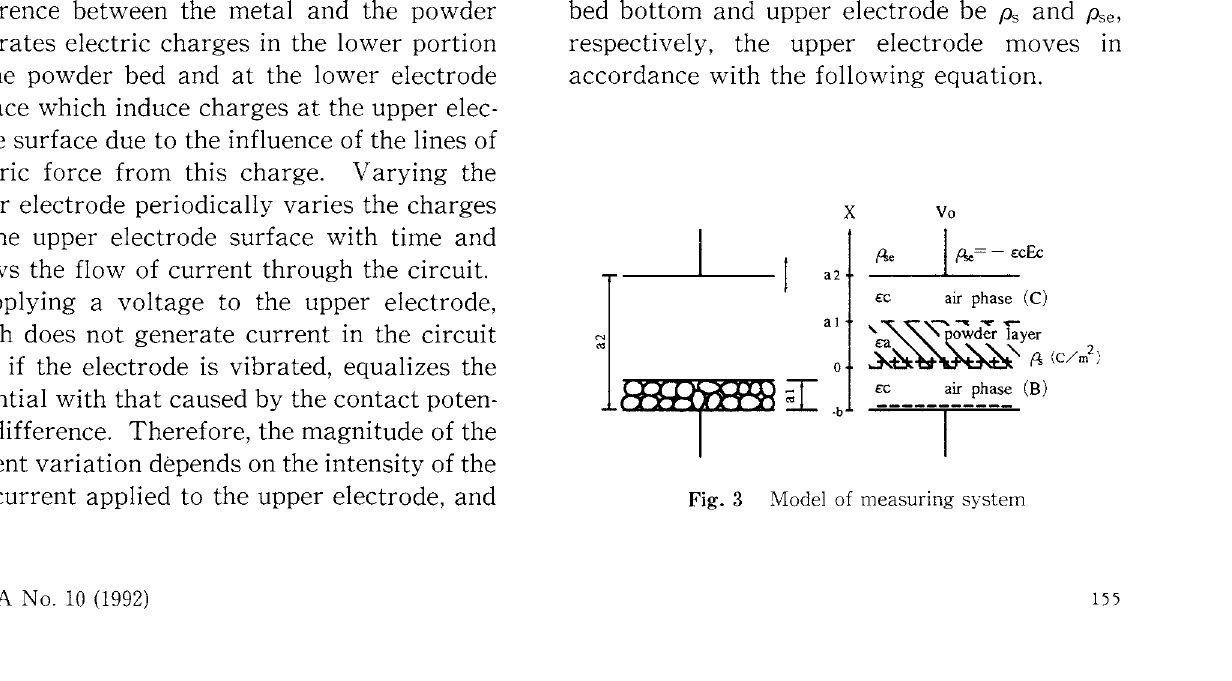
Fig. 3 Model of measuring system